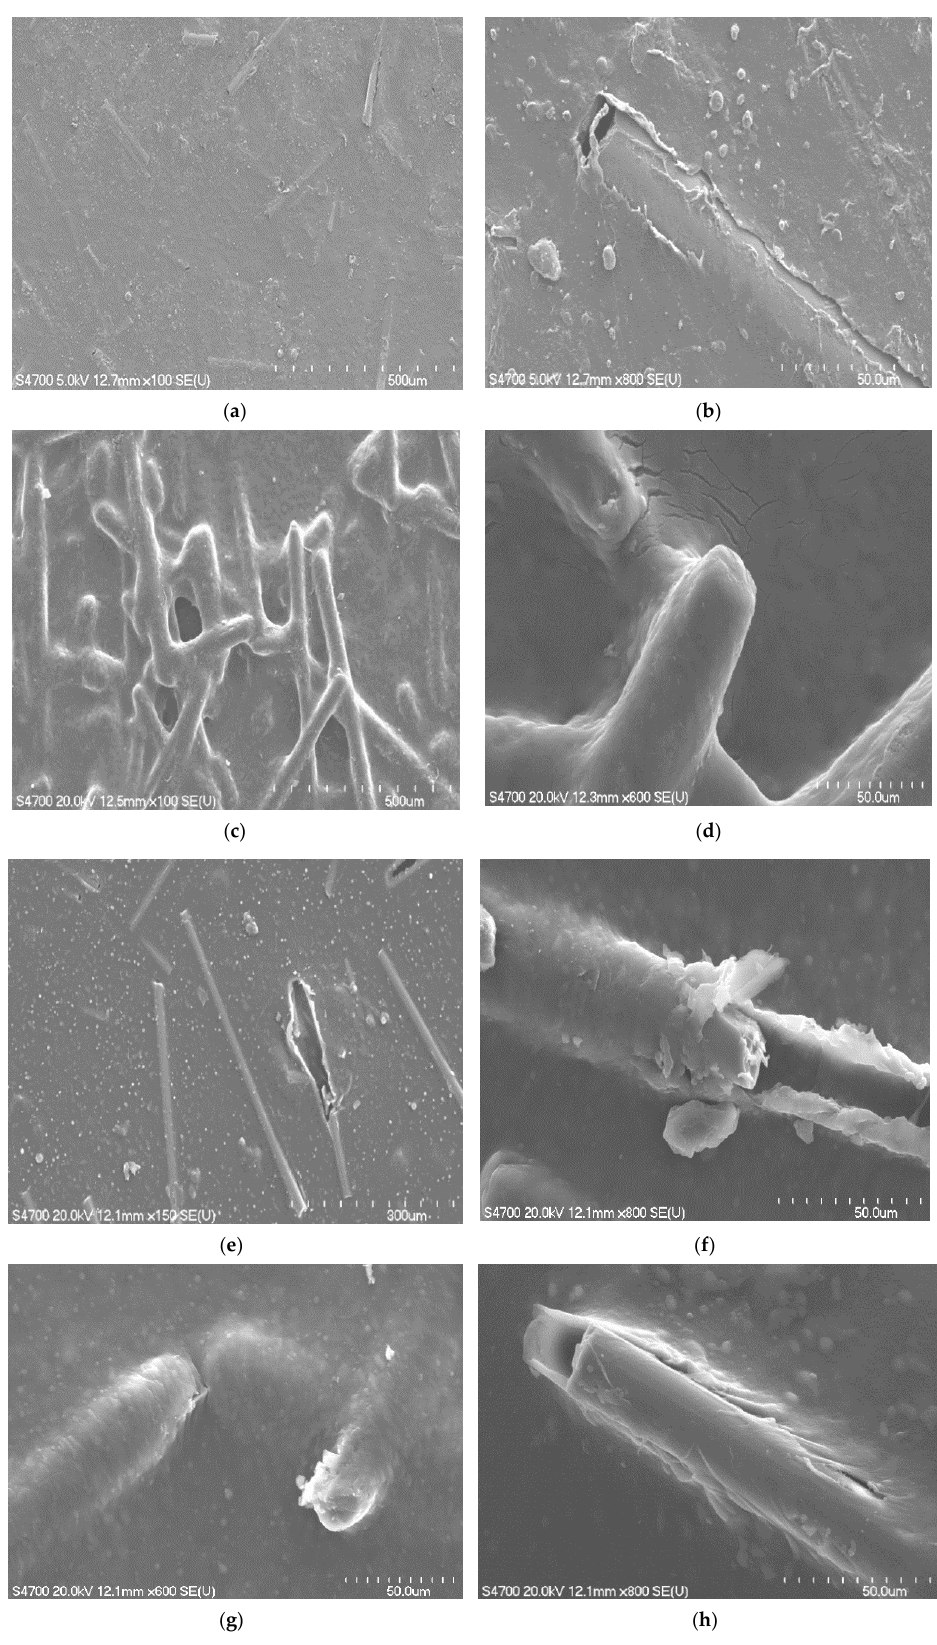
Figure 10. SEM of CEM with glass fiber modified by ( a , b ) 1,6 bis; ( c , d ) 3-MPS; ( e , f ) TES; ( g , h ) PP-g-